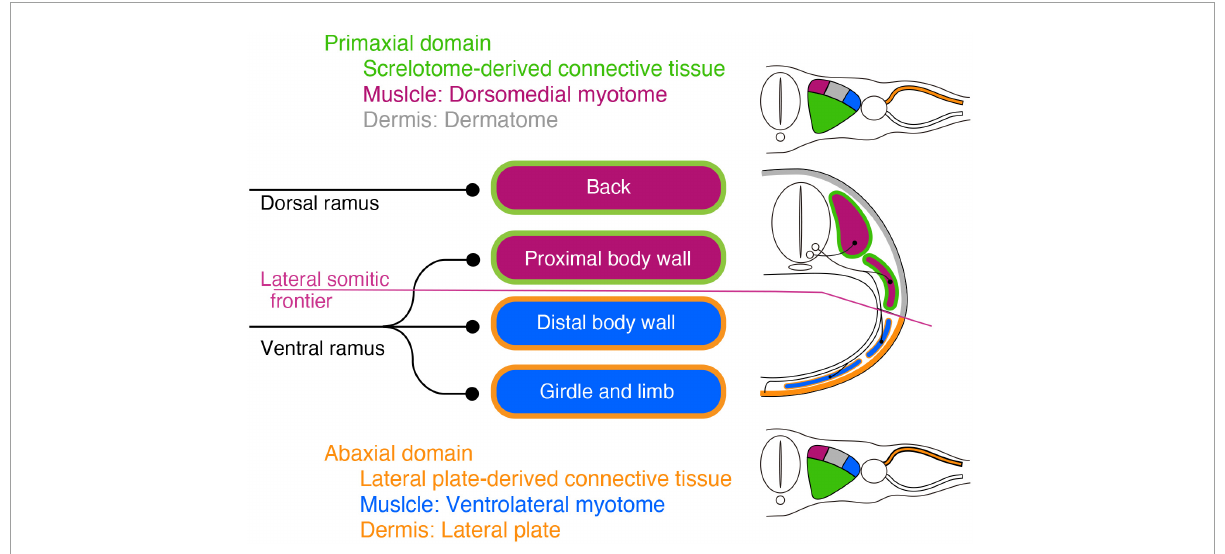
FIGURE1 Schematic illustration of the primaxial and abaxial muscles and their innervations by the dorsal and ventral rami. Primaxial muscle progenitors derive from the dorsomedial myotome (plum-color) and differentiate into the back and proximal body wall muscles within the sclerotome-derived connective tissue (green) environment. Abaxial muscle progenitors are from the ventrolateral myotome (blue) and differentiate into the distal body wall, girdle, and limb muscles within the lateral plate-derived connective tissue environment (oak). The primaxial and abaxial domains are mutually exclusive, and there is a front line, the lateral somitic frontier (amethyst-color), between them. The two main branches, the dorsal and ventral rami, do not fully correspond to the embryonic domains. The dorsal rami innervate the back muscles in the primaxial domain, whereas the ventral rami innervate both the proximal body wall muscles in the primaxial domain, as well as the distal body wall muscles, girdle and limb muscles in the abaxial domain. The dermatome and its-derived primaxial dermis are colored gray. The primaxial dermis derived from the lateral plate mesoderm is colored